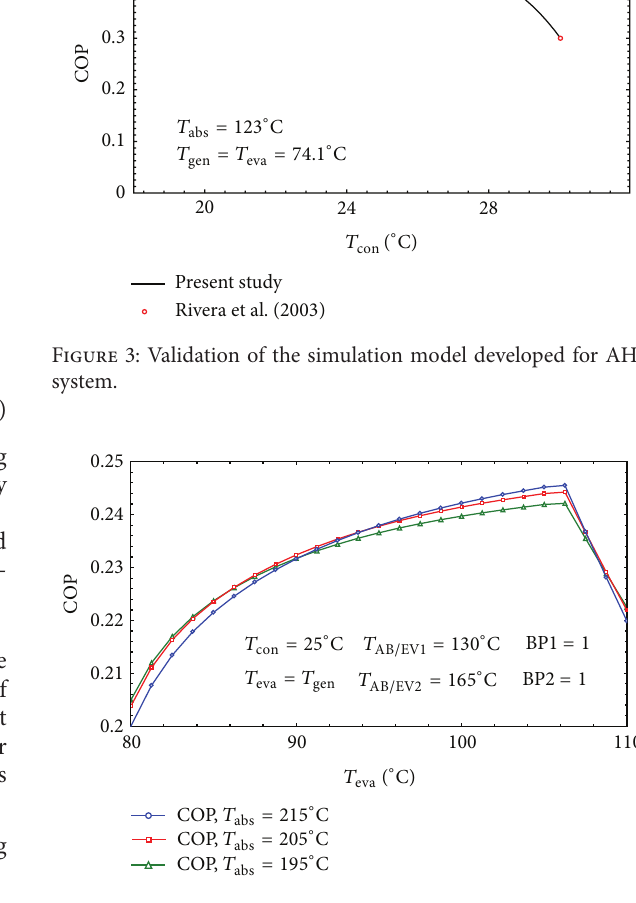
on the COP of the eva